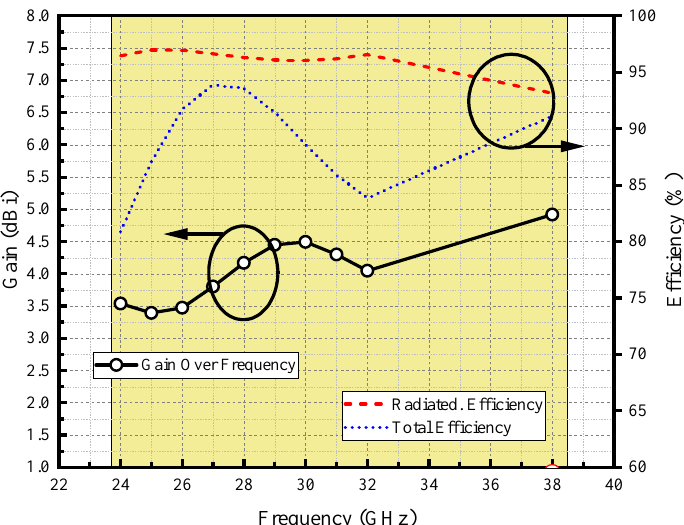
Figure 5. Efficiency and gain of the proposed antenna.